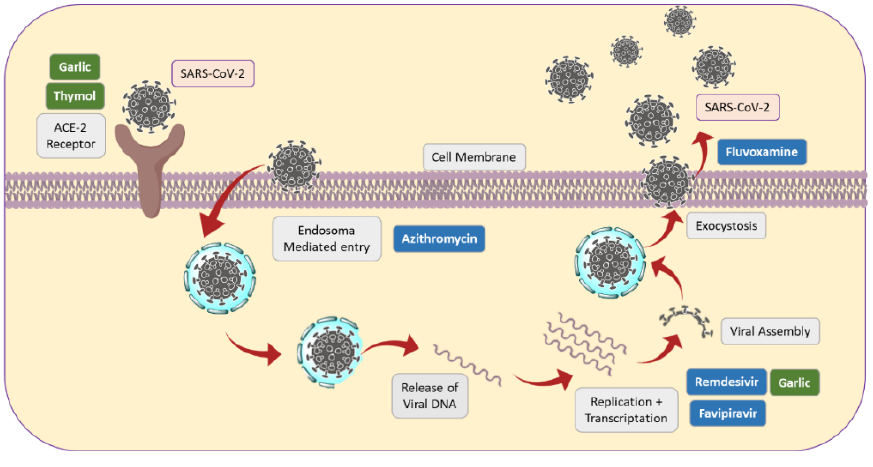
Figure 5. Some key steps of SARS-CoV-2 replication, together with action sites of some drugs and spices.